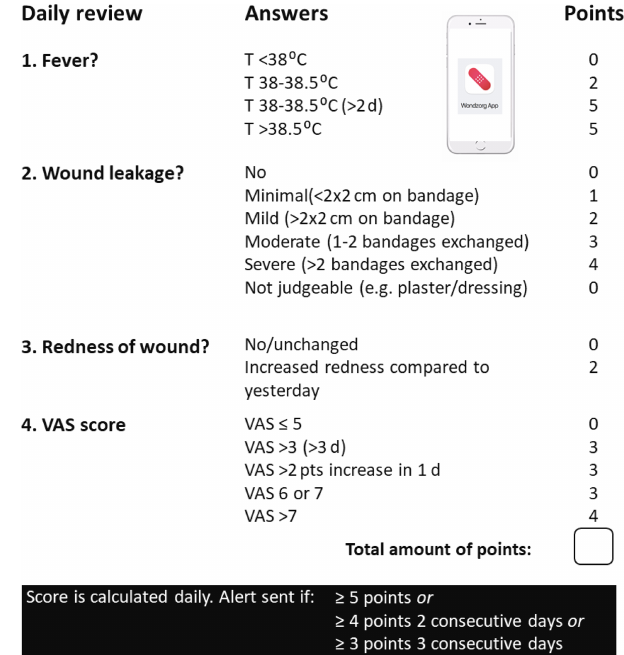
Figure A1. Calculated scores from the app and algorithm for sending alert to patients.